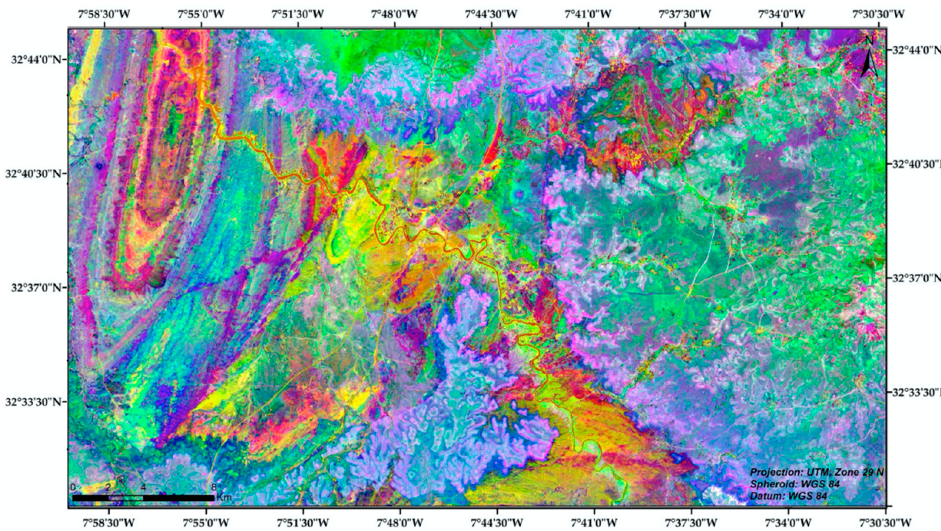
Figure 3. The Sentinel-2A MNF bands (1, 2 and 3)